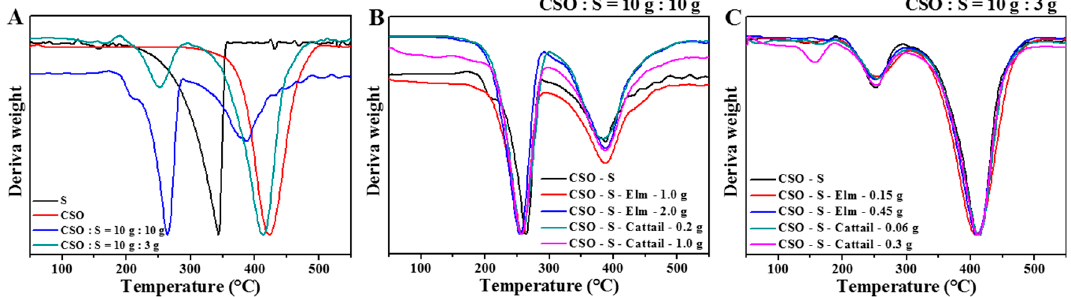
Figure 7. Derivative thermogravimetry (DTG) curves of sulfur, cottonseed oil (CSO) and bio-based polysulfide composites. ( A ) S, CSO, 10.0 g CSO + 10.0 g S, 10.0 g CSO + 3.0 g S, ( B ) 10.0 g CSO + 10.0 g S + elm/cattail, ( C ) 10.0 g CSO + 3.0 g S + elm/cattail.